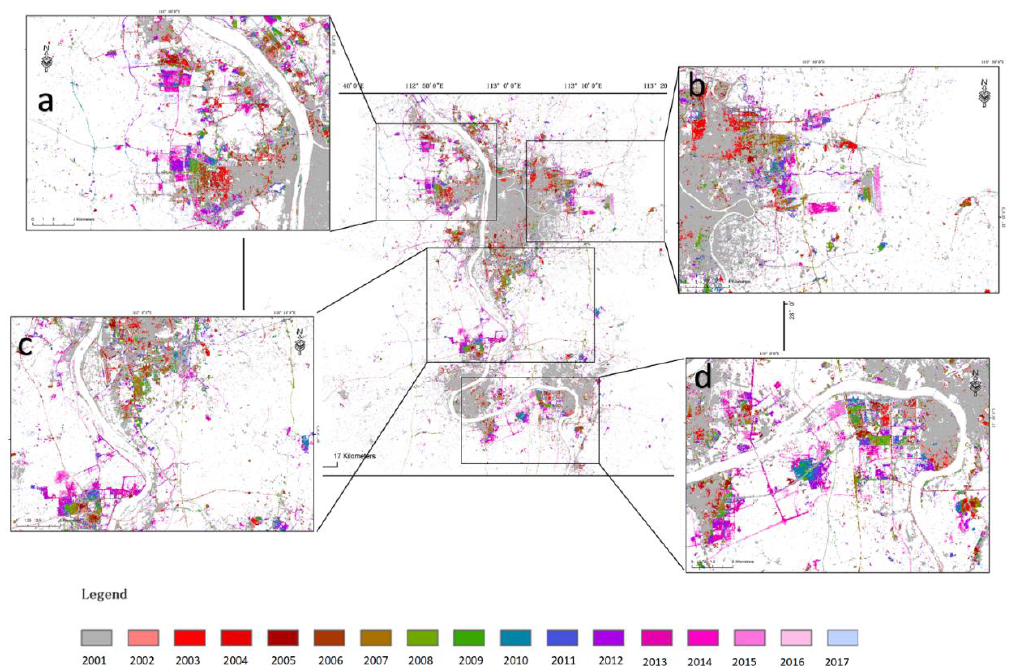
Figure 6. The spatial distribution of the time (in year) of urban expansion (i.e., conversion from non-impervious surface to impervious surface) from 2001 to 2017: ( a ) Wangcheng District; ( b ) Changsha County; ( c ) the core conversation; and ( d ) the junction between Zhuzhou City and Xiangtan